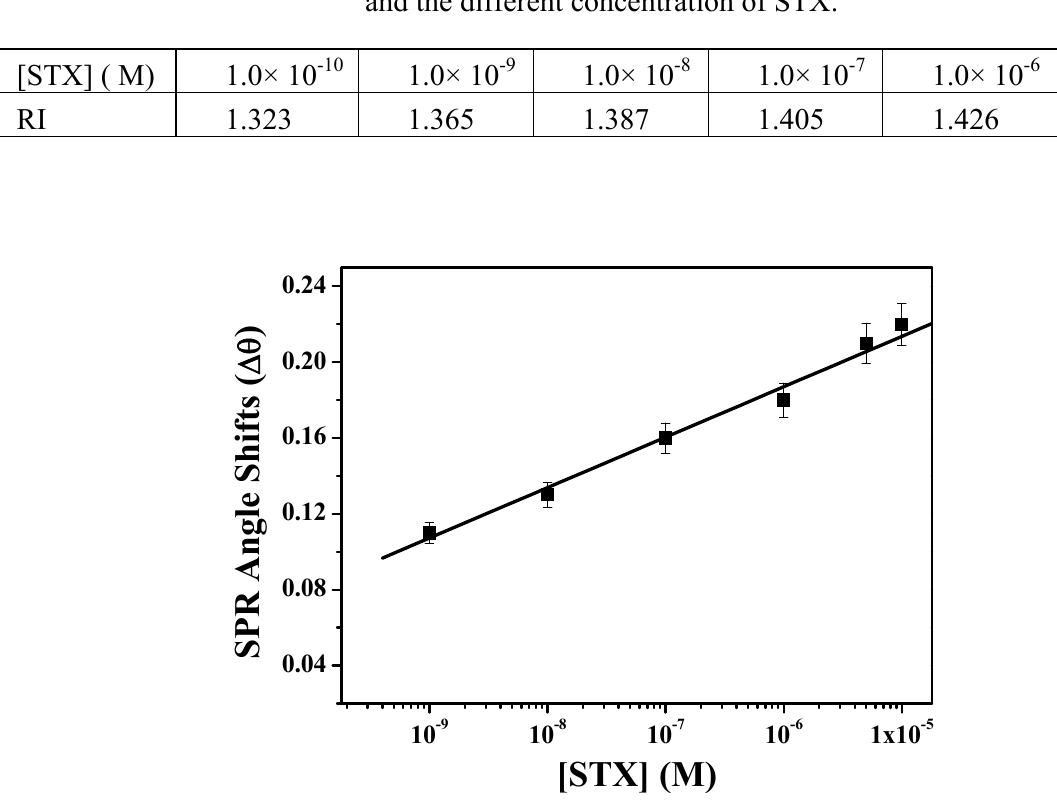
Table 1 . The refractive index (RI) of the interfacial layer according to the interaction between 3 SAM and the different concentration of STX.